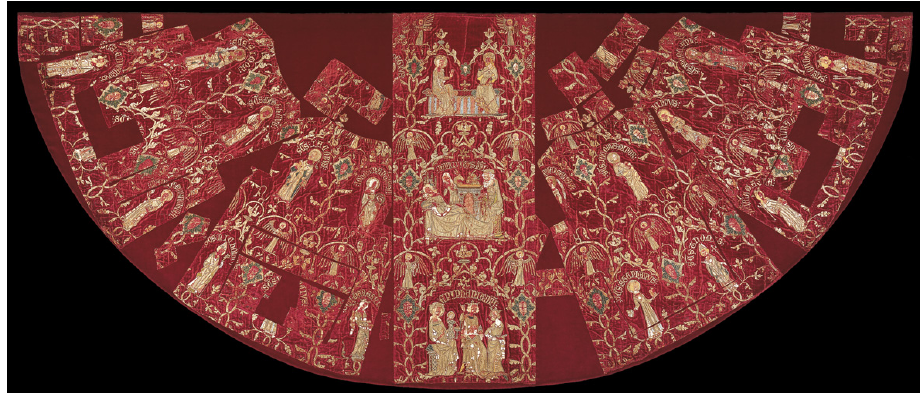
Figure 22. Vic Cope, ca. 1350–1375, from Vic Cathedral. Vic, Museu d’Art Medieval, Spain © MEV, Museu d’Art